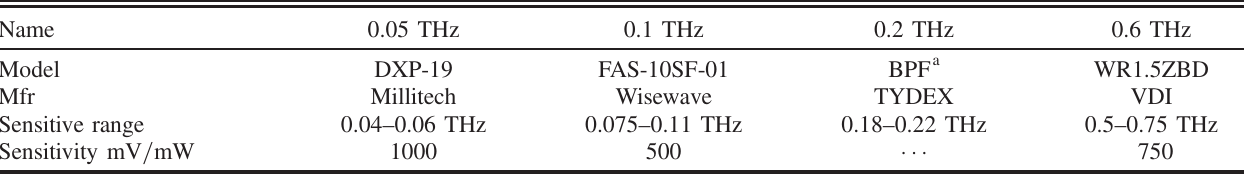
TABLE VI. Specification of Schottky barrier